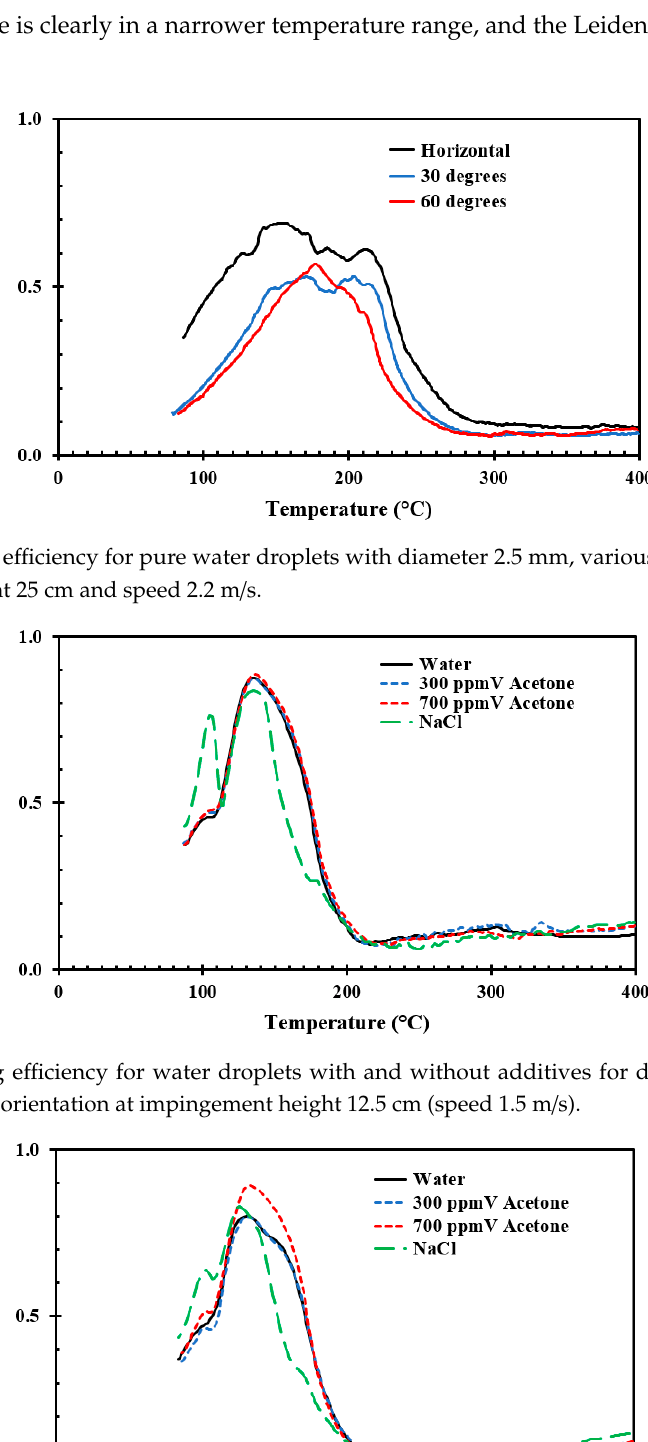
Figure 13. Cooling efficiency for water droplets with and without additives for droplet diameter 2.5 mm, horizontal orientation at impingement height 12.5 cm (speed 1.5 m/s).